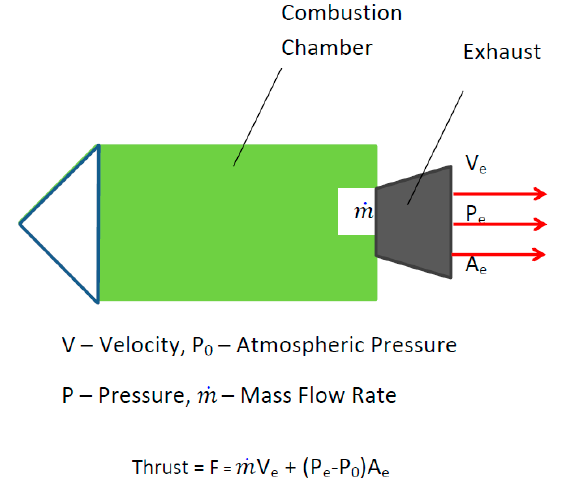
Figure 16. Physics of a Solid Rocket Motor [31].